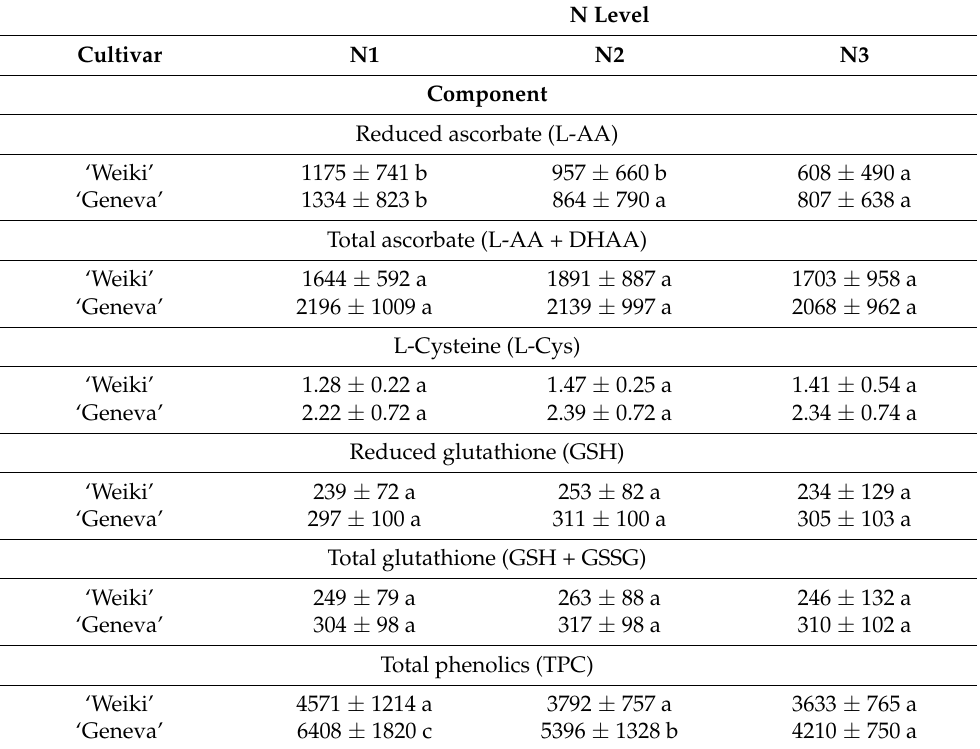
Table 4. Concentration of different bioactive compounds (mg kg − 1 FW) in A. arguta leaves depending on cultivar and soil N level.